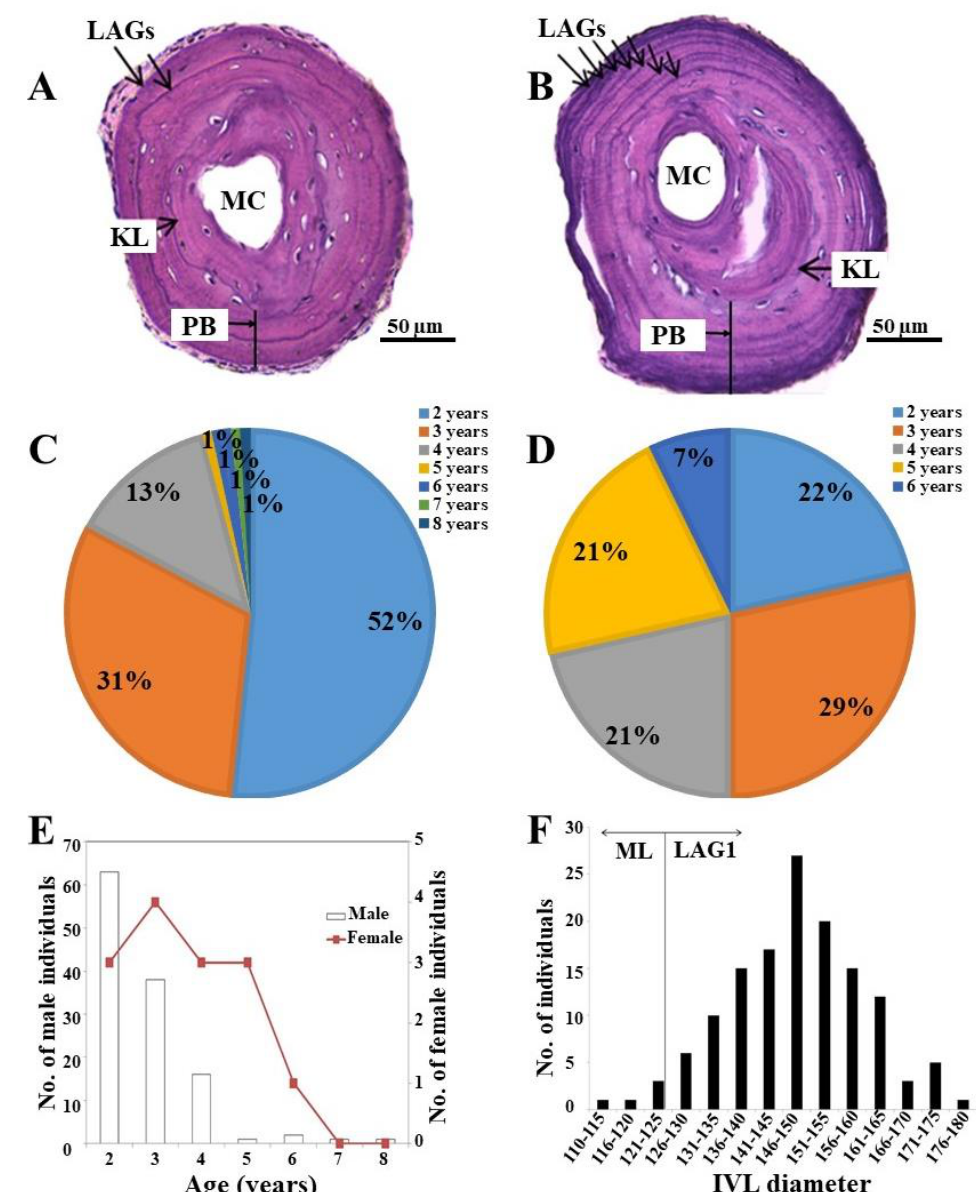
Figure 3. ( A ) Phalangeal cross-section of a two-year-old individual; ( B ) phalangeal cross-section of a seven-year-old individual; ( C ) percentage of age groups of the male community of adult K. borealis population at Lake Sihwa; ( D ) percentage of age groups of the female community of adult K. borealis population at Lake Sihwa; ( E ) age structure in the adult K. borealis population at Lake Sihwa; ( F ) IVL diameter distribution in the adult K. borealis population at Lake Sihwa. ML = metamorphosis line; MC = marrow cavity; PB = periosteal bone; LAG = line of arrested growth; KL = Kastschenco’s line; IVL = innermost visible line.